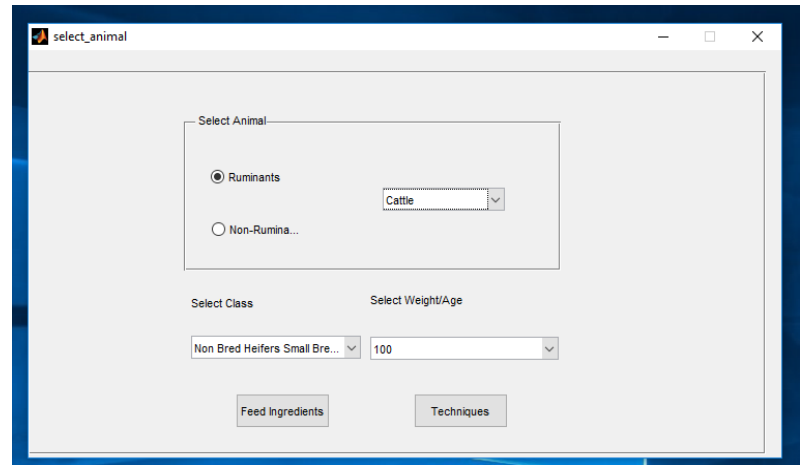
Figure 2. Animal selection